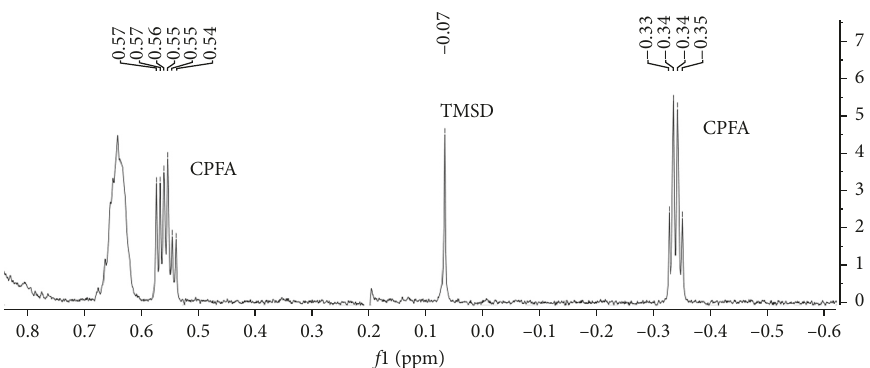
Figure 2: 1 H NMR spectrum (600MHz, CDCl 3 ) of dihydrosterculic acid standard and trimethylsilyl decanol (TMSD) in the very upfield region of the spectrum. The CPFA signal at − 0.34ppm and the TMSD signal at 0.07 ppm were selected for